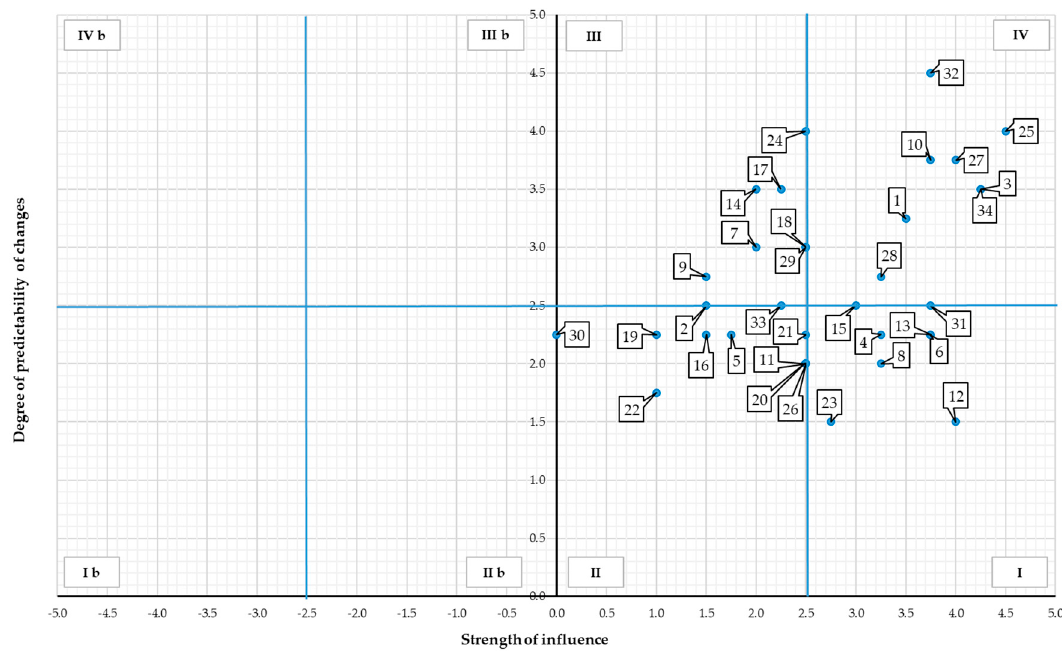
Figure 7. Stakeholder map in the knowledge ecosystem: strength of influence—degree of predictability of change.